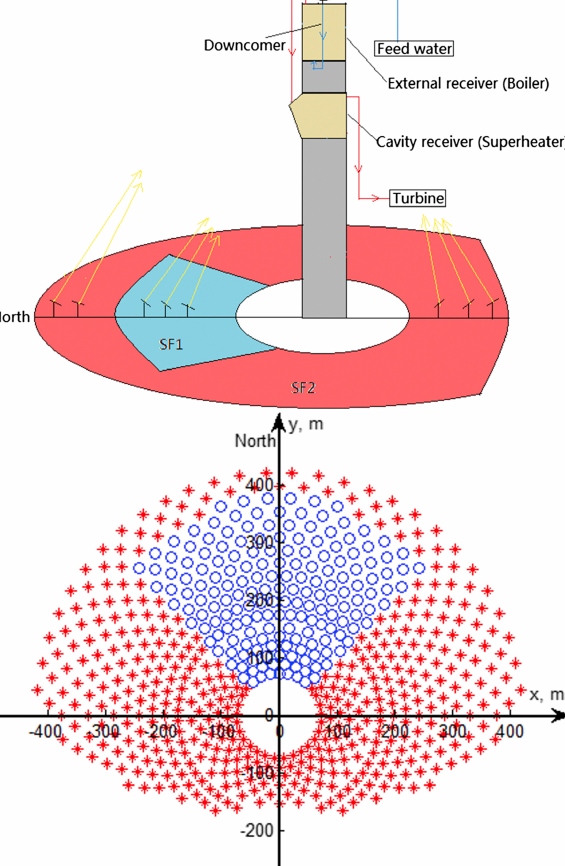
Fig. 4: Schematic diagram of the tower and heliostat field for the dual-receiver proposed in [81]. Reprinted from Applied Thermal Engineering, Vol. 91, Luo, Y., Du, X. and Wen, D., Novel design of central dual-receiver for solar power tower, Pages No. 1071-1081, Copyright (2015), with permission from